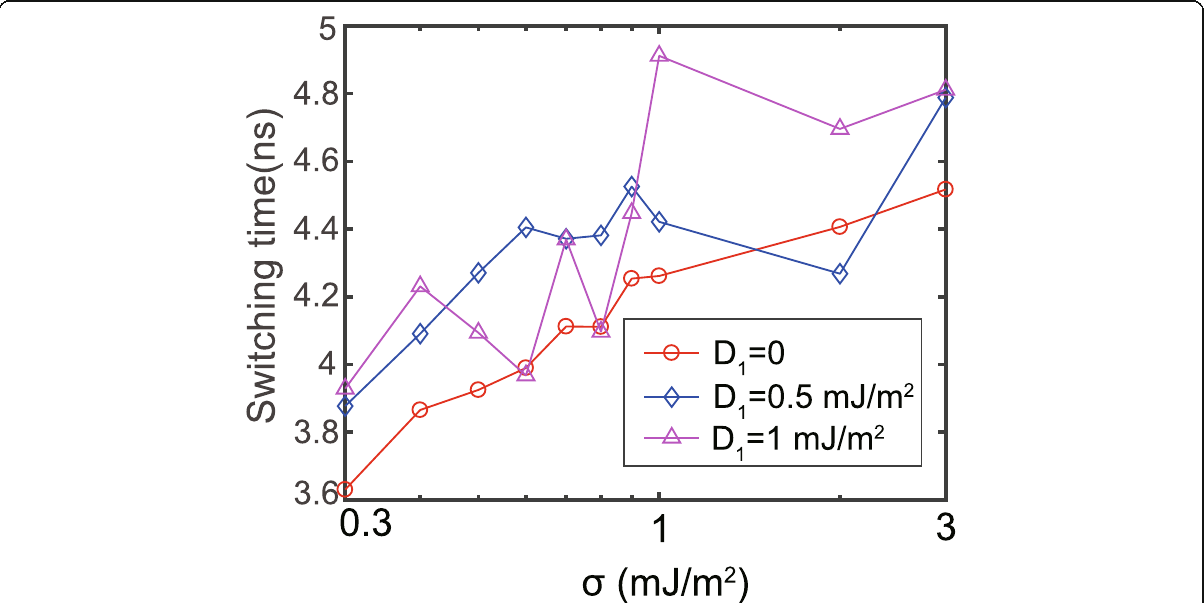
Fig. 2 Switching time as a function of RKKY strength, with σ shown in the logarithm scale. D 1 and D 2 are set to the same values, but with the opposite